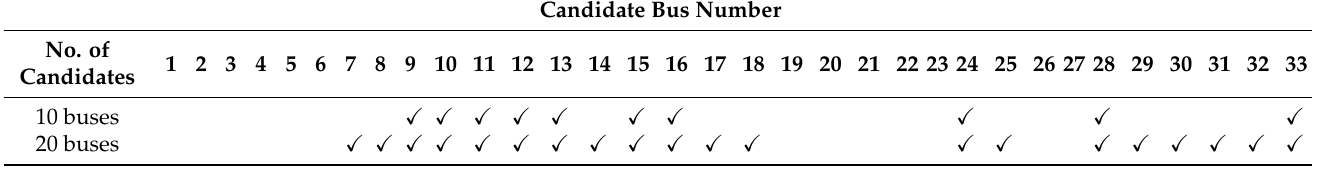
Table 4. Type-3 candidate buses.